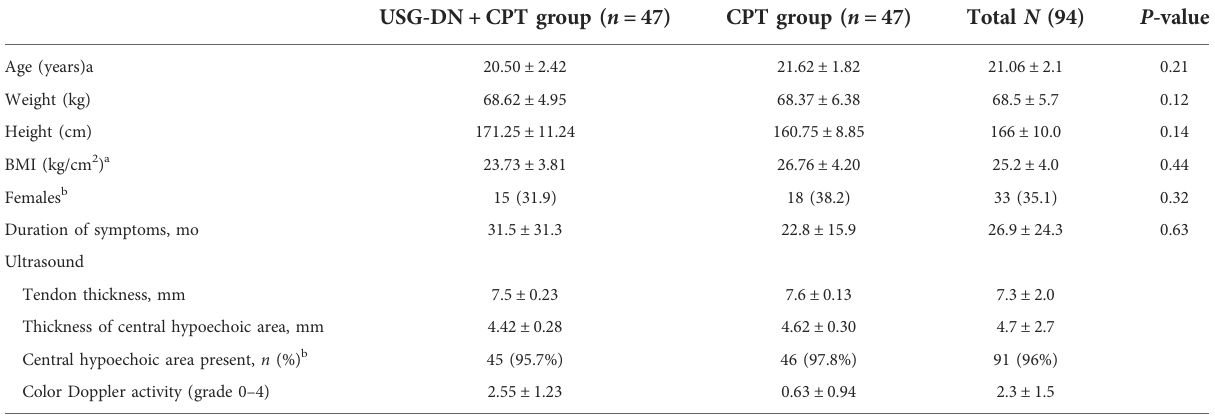
TABLE 2 Baseline demographic